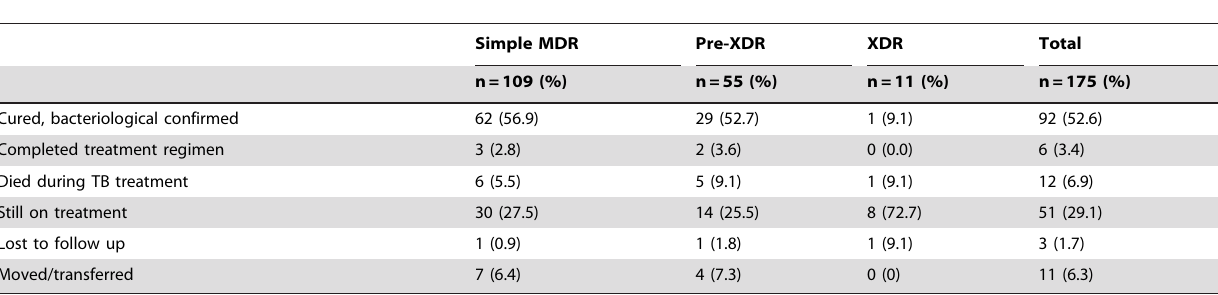
Table 2. Treatment outcome of tuberculosis patients with MDR TB, pre-XDR TB, and XDR TB.